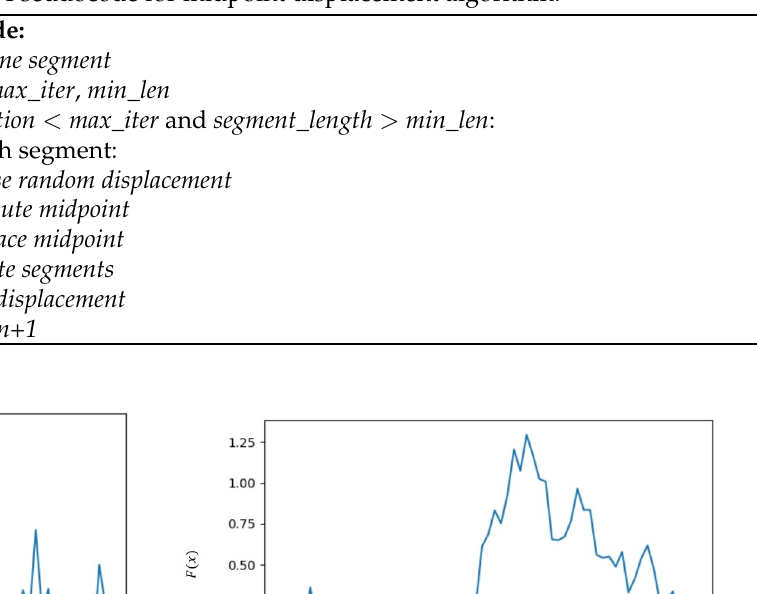
Algorithm 1: Pseudocode for midpoint displacement algorithm.